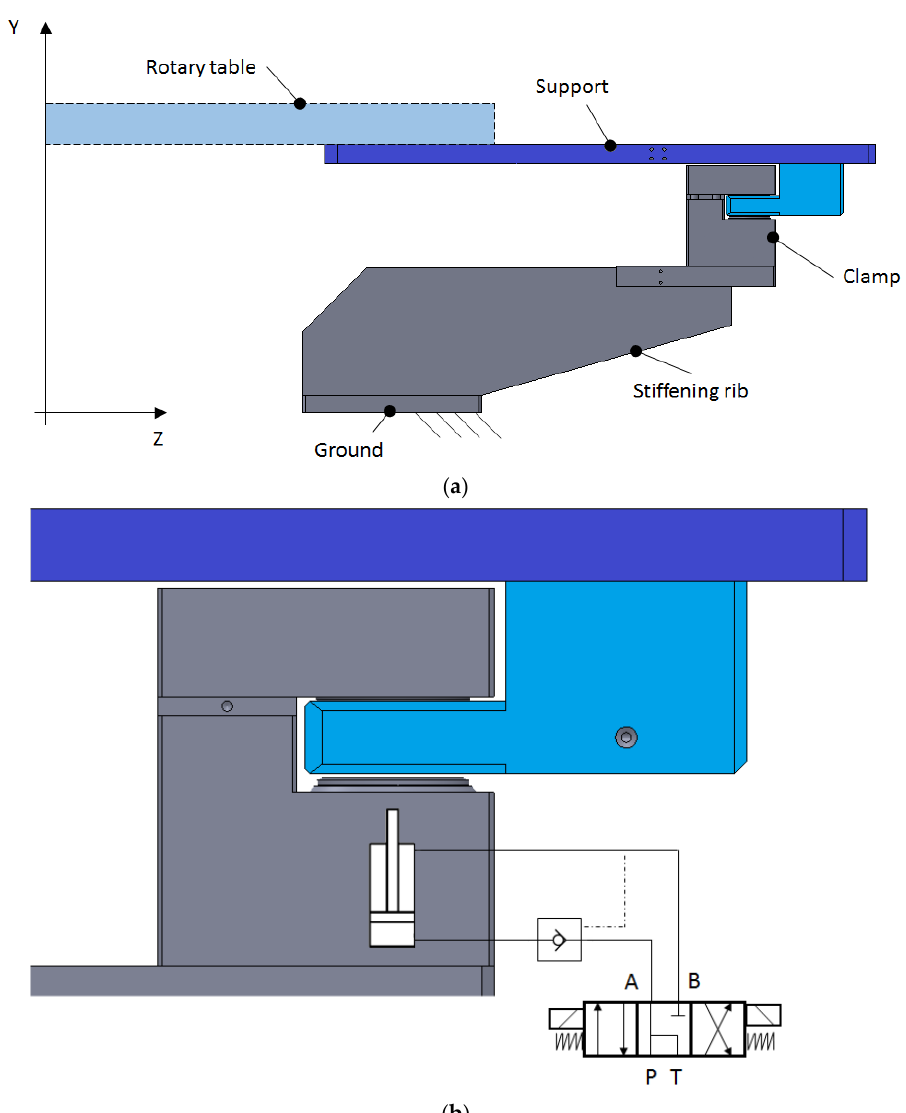
Figure 21. Hydraulic locking clamp ( a ) nomenclature and geometry and ( b ) operating principle and hydraulic schematic (P—pressure line, T—tank line).